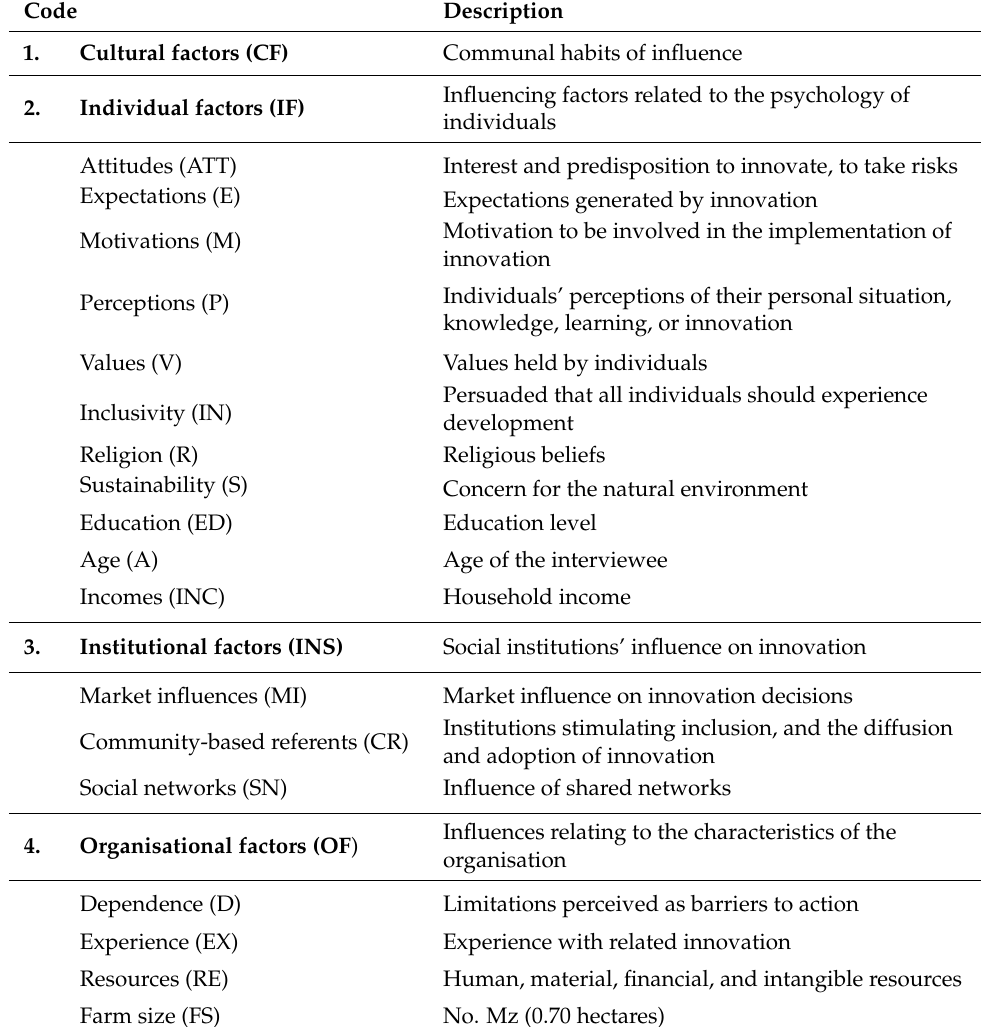
Table 3. System of categories for